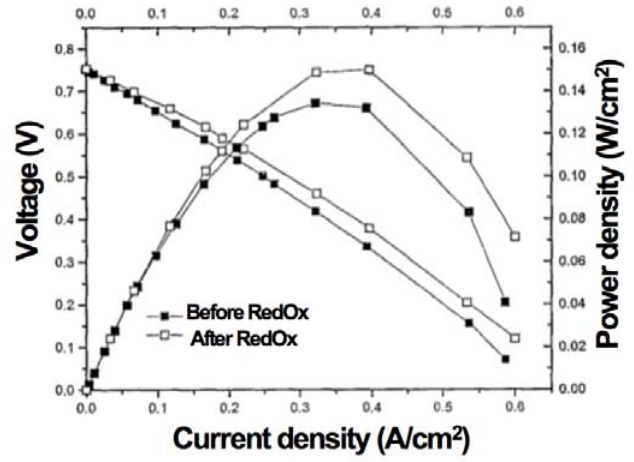
Sr ) Cr Mn O (LSCM) (47.5 wt %) + CGO (47.5 wt %) + NiO 0.75 0.25 1 − x 0.5 0.5 3 with 150 mW/cm 2 at 750 °C before and after RedOx cycles [248]. 4